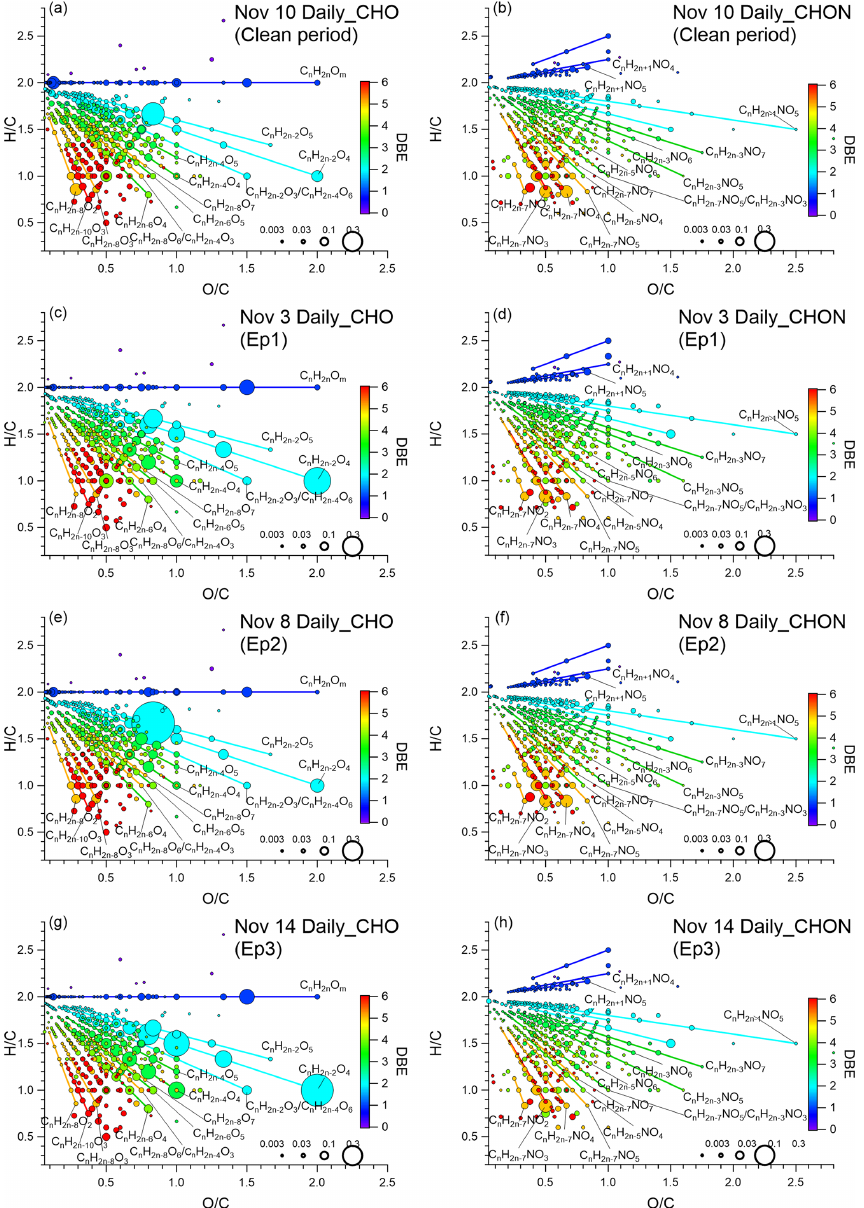
Figure 4. (a) Van Krevelen (VK) diagram of CHO compounds in the clean period (10 November); (b) VK diagram of CHON compounds in the clean period (10 November); (c) VK diagram of CHO compounds in Ep1 (3 November); (d) VK diagram of CHON compounds in Ep1 (3 November); (e) VK diagram of CHO compounds in Ep2 (8 November); (f) VK diagram of CHON compounds in Ep2 (8 November); (g) VK diagrams of CHO compounds in Ep3 (14 November); (h) VK diagram of CHON compounds in Ep3 (14 November). Each dot represents an identified compound with its H / C and O / C ratios and color-coded by its DBEs. O / C ratios in CHO and CHON groups were calculated from the atomic numbers in the formulae. The size of symbols is proportional to the square root of the relative contribution to the CHO X signal of each compound. The same Van Krevelen (VK) diagrams of CHO and CHON compounds but color-coded by the compounds’ carbon number in the clean period, Ep1, Ep2, and Ep3 are shown in Fig.